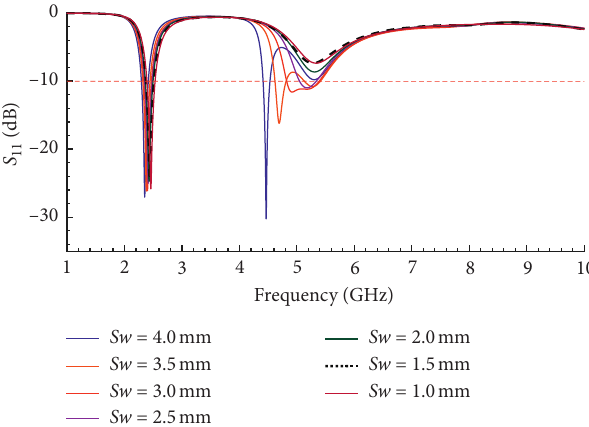
S l variation in Carica papaya BioAs-